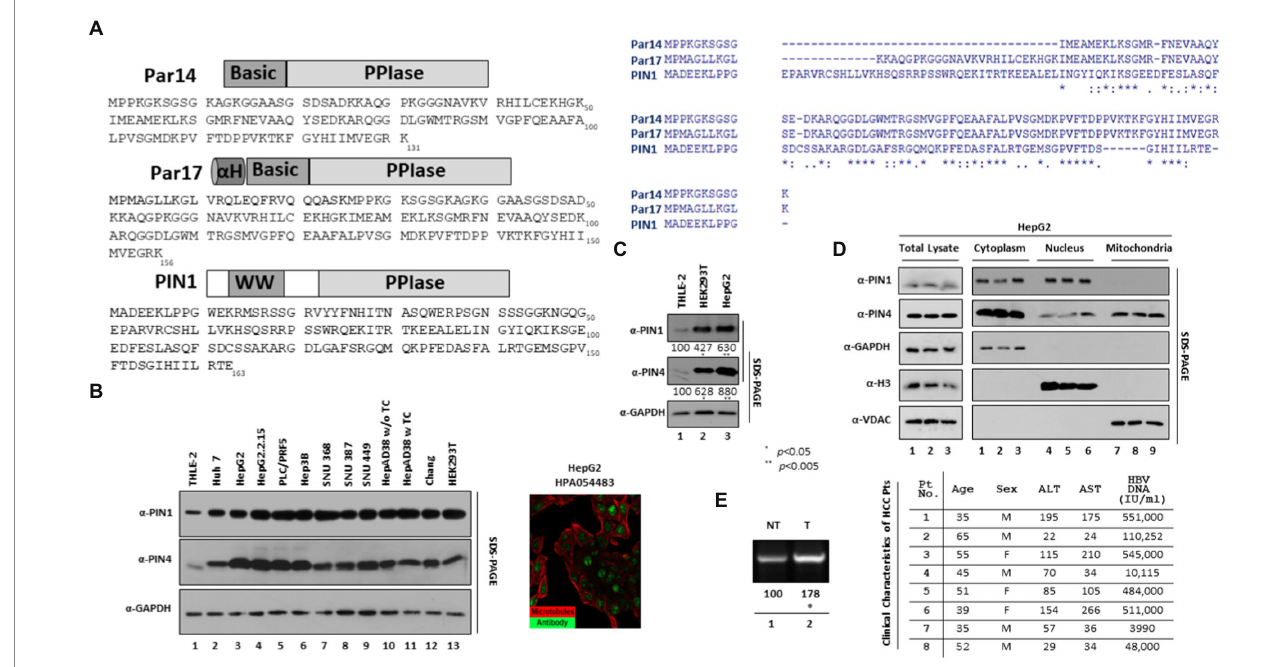
FIGURE 1 Endogenous expression of PIN1 and PIN4 (Par14/Par17) in selected HCC cells. (A) Sequence of PIN1 and PIN4 (Par14 and Par17) proteins. The PIN1 protein is comprised of 163 amino acids constituting two important domains, WW and PPIase domains. The PIN4-encoded Par14 is comprised of 131 amino acids, which form the N-terminal DNA binding Basic domain and PPIase domain. Similar to Par14, the PIN4-encoded Par17 has additional 25 amino acids alpha- helical domain prior to Basic and PPIase domains. Amino acid sequence analysis of PIN1, Par14, and Par17 was made by ClustalW2. (B) Selected HCC cell lines express higher levels of endogenous PIN1, and PIN4 proteins than THLE-2 immortalized human liver epithelial cells. THLE-2 (lane 1), Huh7 (lane 2), HepG2 (lane 3), HepG2.2.15 (lane 4), PLC/PRF5 (lane 5), Hep3B (lane 6), SNU368 (lane 7), SNU387 (lane 8), SNU449 (lane 9), HepAD38 in TC-containing (lane 11) or TC-depleted media (lane 10), Chang (lane 11), and HEK293T (lane 12) cells were plated at equal densities (2 × 10 6 cells per 6 cm plate). Human Protein Atlas PIN4 expression in HepG2 is shown with reference-ID HPA054483. (C) Relative PIN4 gene product levels in THLE-2, HEK293T, and HepG2 cells. THLE-2 (lane 1), HEK293T (lane 2), and HepG2 cells (lane 3) were seeded as described above. At 72 h post-seeding, equal quantities of protein (as determined by Bradford Assay) from cell lysates, as described previously (Piracha et al., 2018). (D) PIN1 is localized to cytoplasm and nucleus, while PIN4 protein was localized in nuclear, cytoplasmic, and mitochondrial regions. HepG2 cells were seeded in 6 cm plates in triplicate (lanes 1–3). At 72 h post- transfection, the cellular fractions were prepared as described in the “Material and Methods” section. SDS-PAGE and immunoblotting (with mouse monoclonal anti-PIN1, rabbit monoclonal anti-PIN4, rabbit polyclonal anti-Myc, mouse monoclonal anti-GAPDH, rabbit polyclonal anti-H3, and mouse monoclonal anti-VDAC antibodies) were performed. (E) cccDNA levels in paired tumor and adjacent nontumor liver biopsy samples from patients with HBV-HCC. Cellular lysates from biopsy samples were prepared in the weight per volume w/v ratio in the mPER buffer, as described previously (Piracha et al., 2020). cccDNA levels were determined from clinical samples using cccDNA-specific primers as described in the “Material and Methods” section. The clinical parameters of the patients including Age, Sex, ALT, AST, and HBV DNA (IU/ml) are shown. Data are shown as representations from independent three experiments. The statistical significance values were determined using Student’s t -test. * p < 0.05, ** p < 0.005 relative to